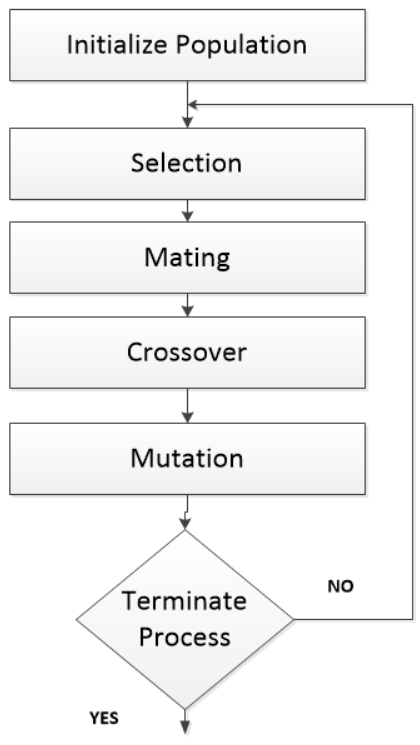
Figure 7. Pseudo-code for the Genetic Algorithm